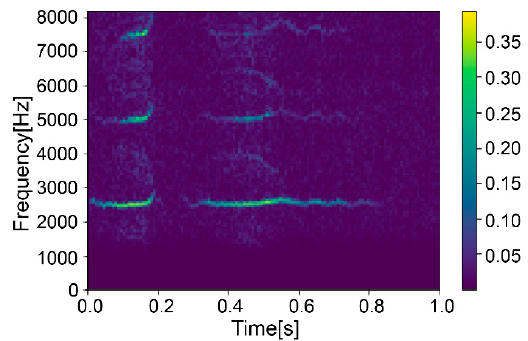
Figure 5. Time–frequency graph in short-time Fourier transform.